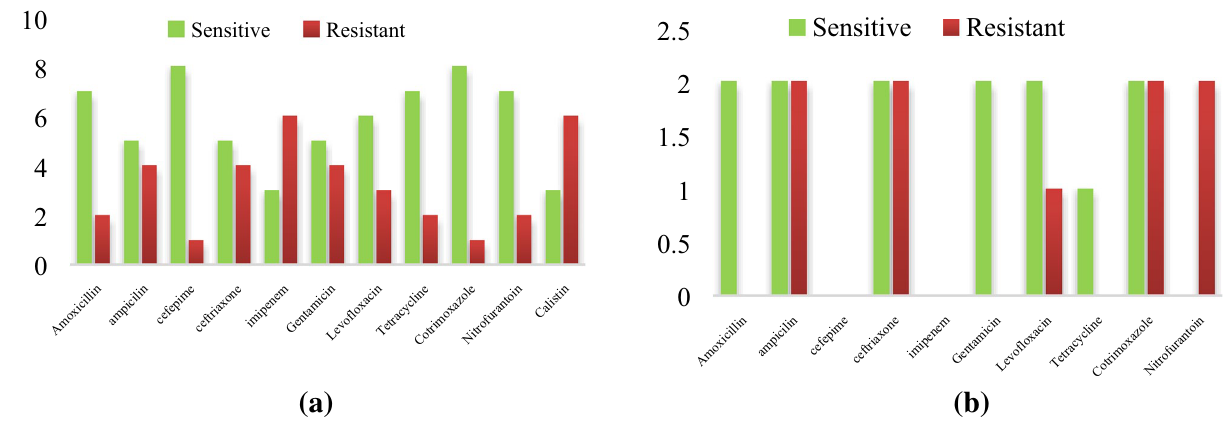
Figure 6. ( a ) Antibiogram of K.pnemoniae isolated from medical devices in NICU. ( b ) Antibiogram of E.coli isolated from medical devices in NICU. Among Entero-bacteriaceae, 9 Klebsiella pneumoniae and 2 E.coli both of them show sensitivity for colistin and